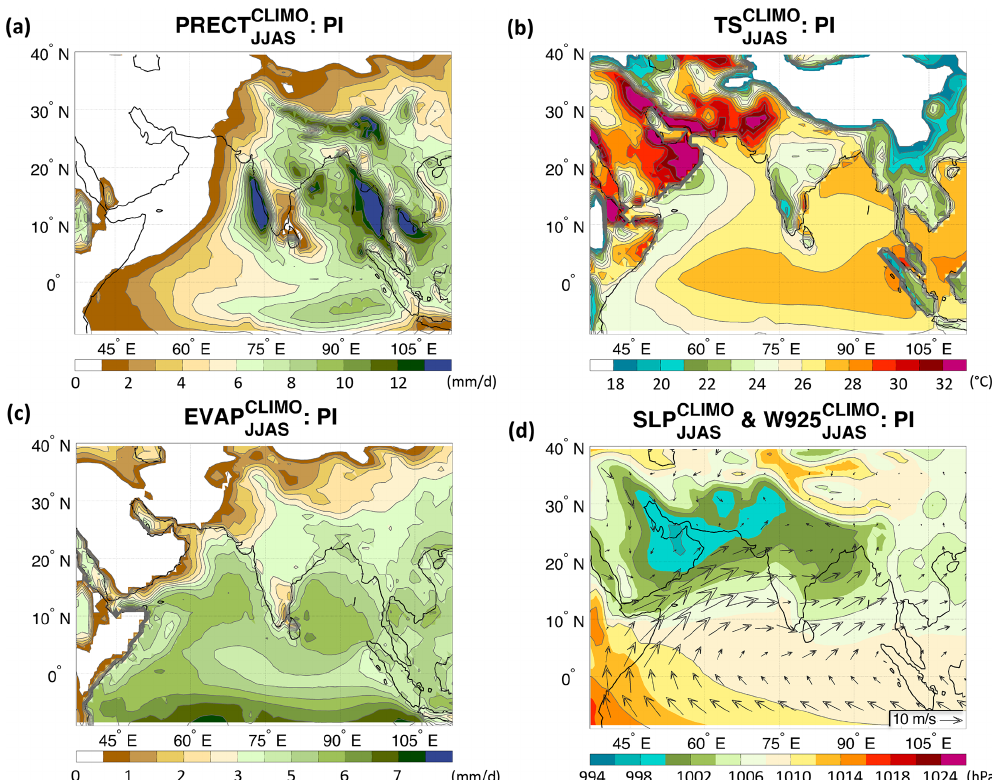
Figure 1. (a) Climatological summer (JJAS) precipitation (PRECT, mm/d); (b) surface temperature (TS, ◦ C); (c) evaporation (EVAP, mm/d); and (d) sea level pressure (shadings, SLP, hPa) and 925hPa wind (arrows, W925, m/s) for the PI experiment. The contour lines follow the color-bar